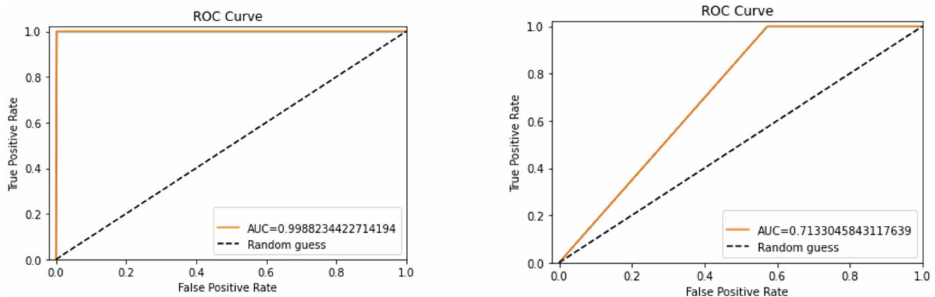
Figure 14. ROC curve related to generated dataset.